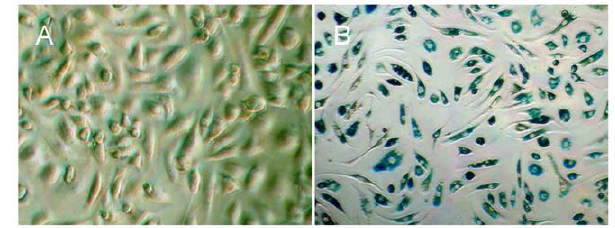
Figure 1. spleen-derived EPCs. EPCs showed endothelium-like cobblestone morphology with characteristic formation of clusters (A). Blue particles are clearly visible in almost every labeled cell with Prussian blue staining (B). (Magnification 6 200).